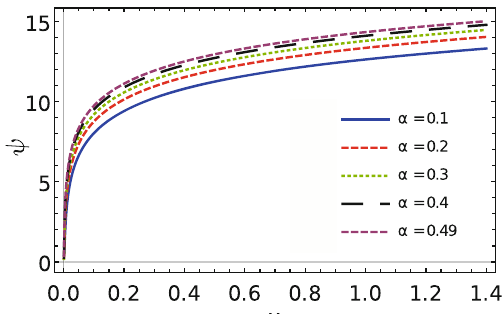
Fig. 1 e ν as function of x for α = 0 . 2 and different values of n